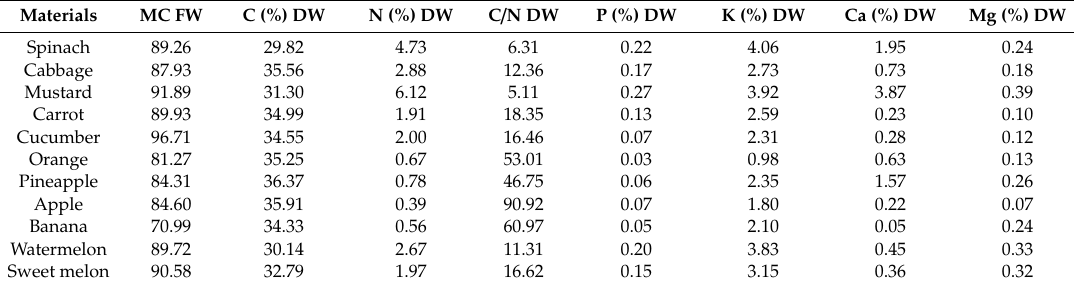
Table 1. Fruit and vegetable waste (FVW) used in co-composting.